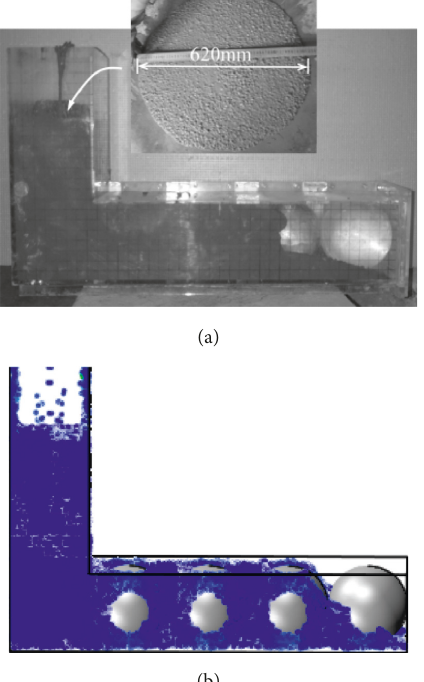
Figure 8: Final shape of SCC in the enhanced L-box test. (a) Experiment [24] and (b)